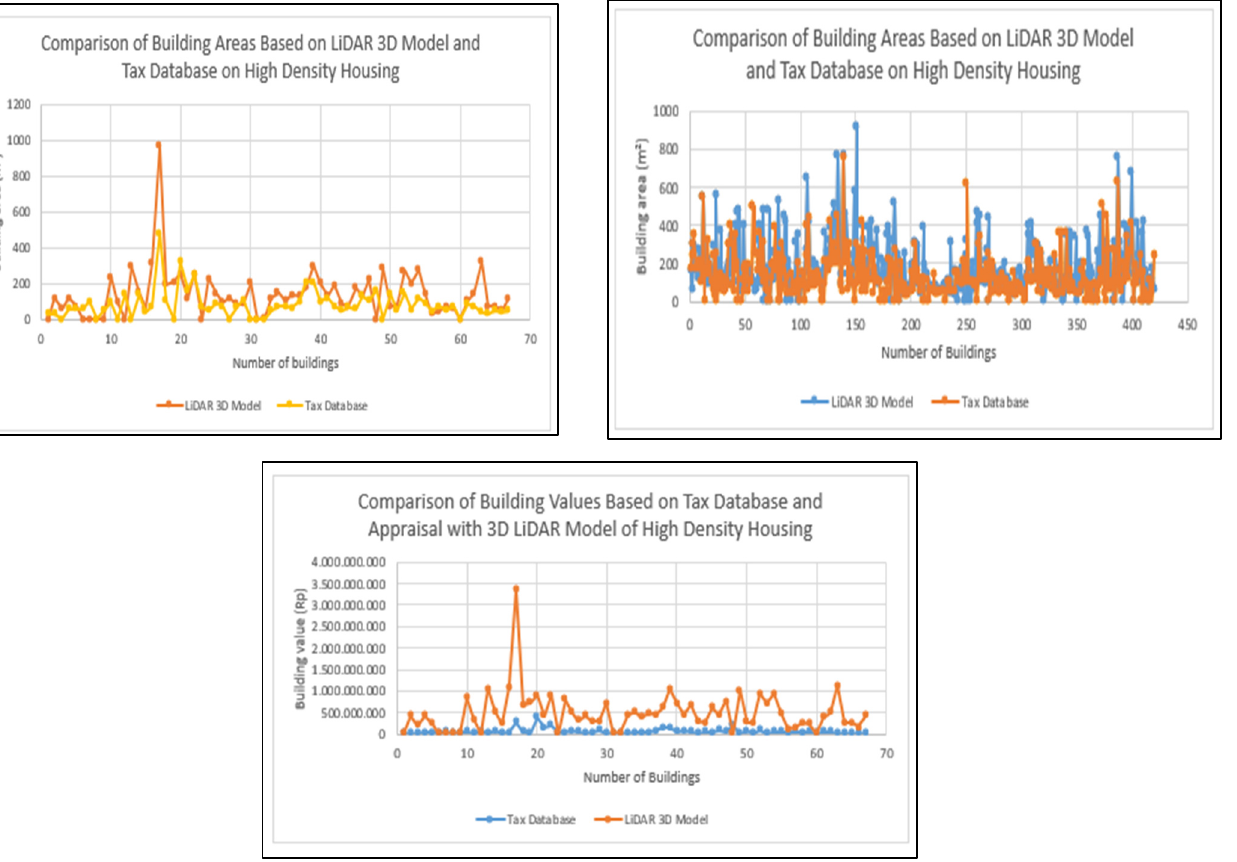
Figure 7. Area Comparison Graph Based on the 3D LiDAR. Model. ( Source: data processing docu- mentation) .